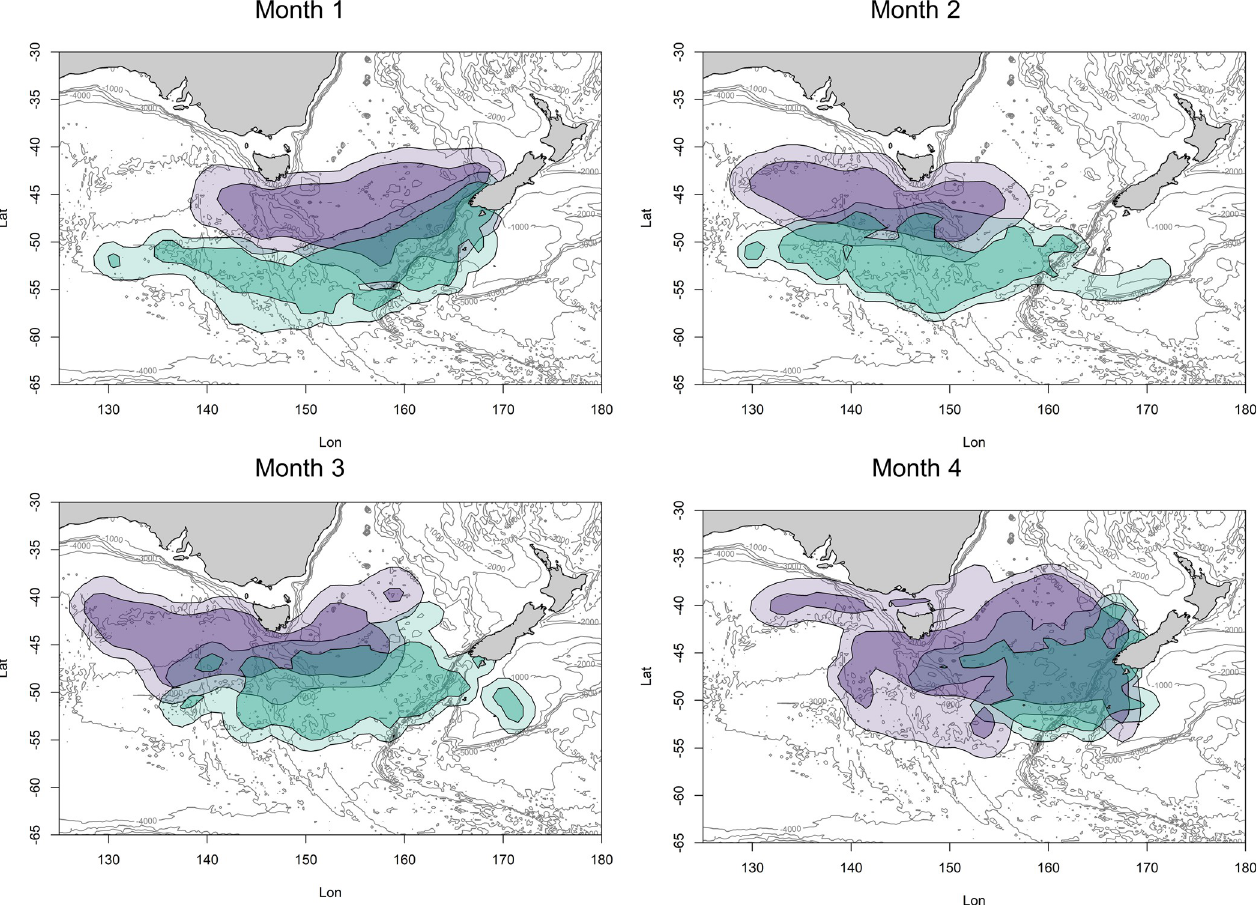
Fig 7. The synchronous core (50% UD) and peripheral (90% UD) non-breeding distributions for Snares (purple) and Fiordland (turquoise) penguins. The start of the Fiordland penguins migration was shifted later in time by two months to coincide with the start of the Snares penguins migration ( i . e . the Fiordland penguin distribution for March was shifted to May, etc.). February (the month when the Fiordland penguins first set out) and September were excluded as they only represented one week of data each.